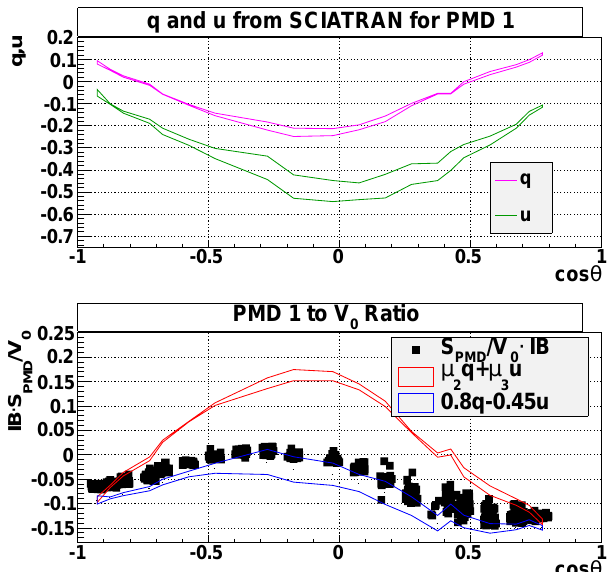
Fig. 6. Top panel: expectation values for q and u for August 2004 data at TH ≈ 21 . 7km from SCIATRAN set 0; the curves depict the RMS around the mean value. Bottom panel: the points are the data for PMD 1 (LHS of Eq. 14) and the red curve represents the RMS around the expectation value of the RHS of this equation using av- erages of on-ground key data, while the blue curve represents the i = 0 . 8 and h µ P i = − 0 . values obtained by setting h µ P 2 3